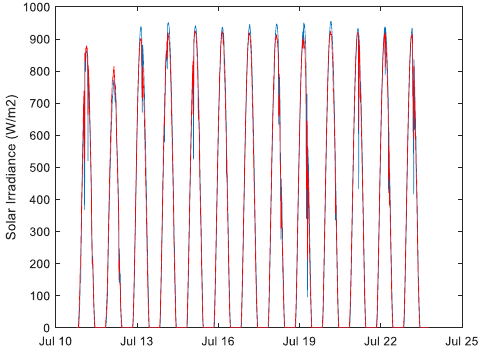
Figure 13. Measured (blue) and one-step-ahead predicted (red) R.